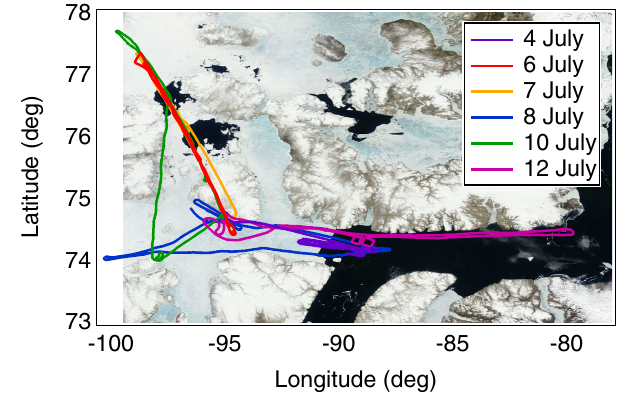
Figure 2. Satellite image (visible range from MODIS) from 4 July 2014 with a compilation of flight tracks conducted during 4–12 July 2014 (indicated with different